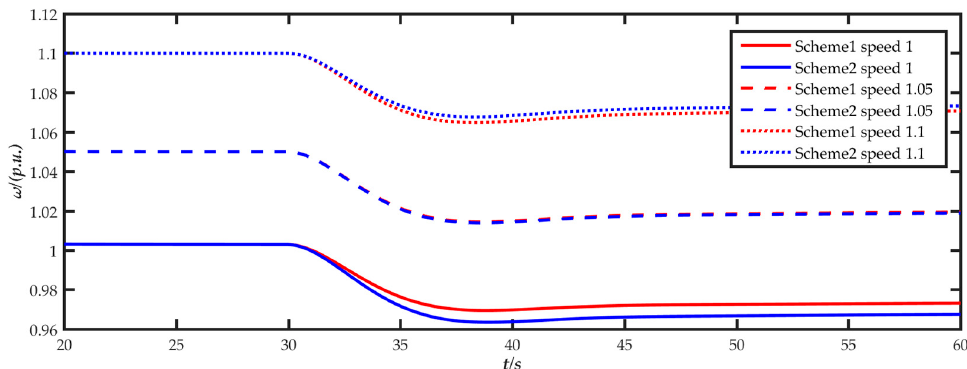
Figure 13. Speed change in wind turbines in the high-wind speed zone.